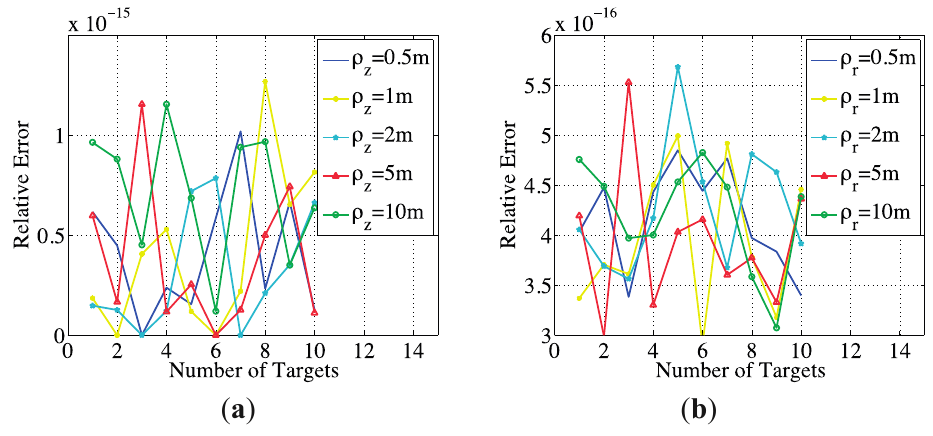
Figure 5. ( a ) Relative imaging errors w.r.t. numbers of targets under different depth resolutions with ρ r = 2 m fixed; ( b ) Relative imaging errors w.r.t. numbers of targets under different range resolutions with ρ z = 2 m fixed.